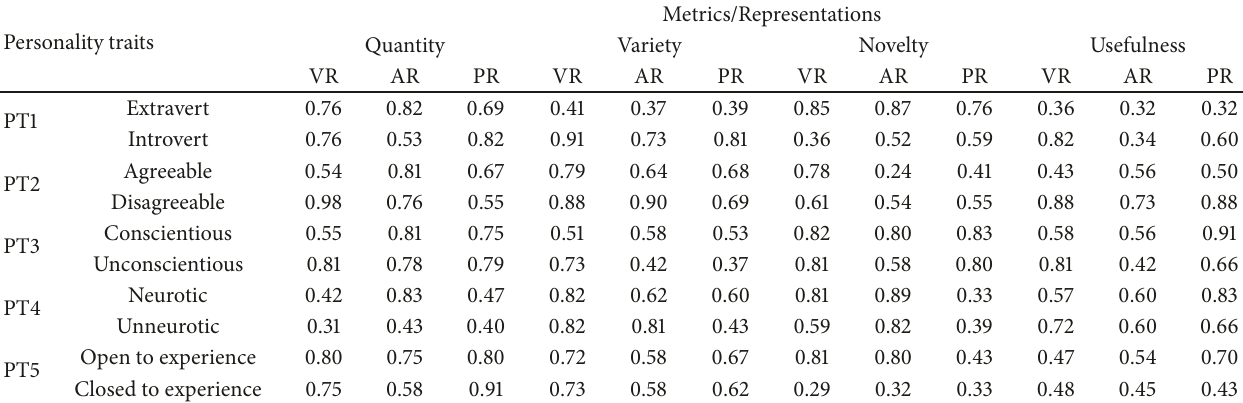
Personality traits